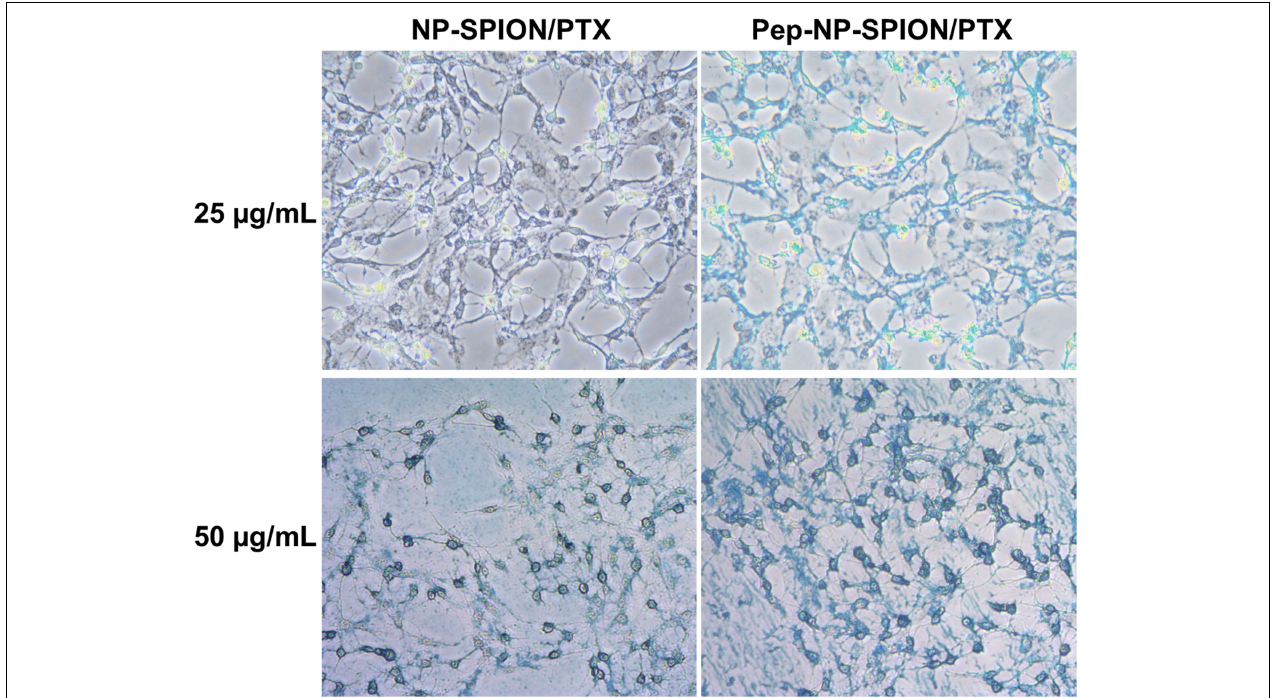
FIGURE 5 | Prussian blue staining images of C6 cells after 1 h incubation with NP-SPION/PTX and Pep-NP-SPION/PTX with Fe concentration at 25 and 50 µ g/mL. Original magnification: 200 × .